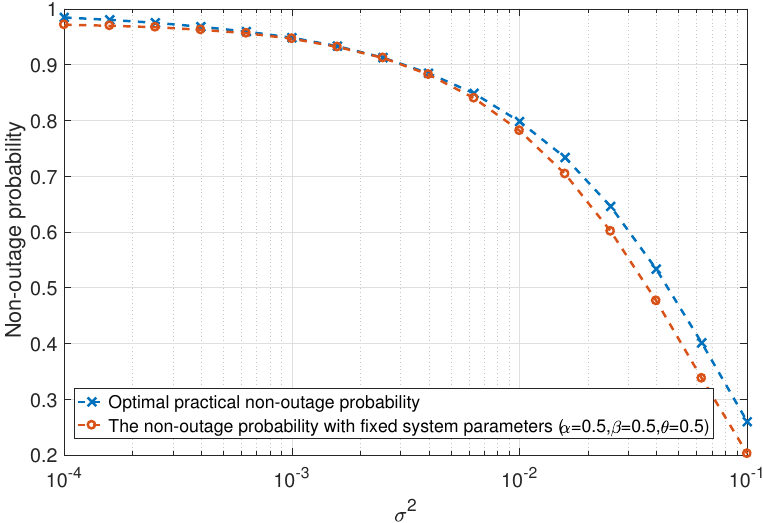
Figure 5. The non-outage probability as a function of noise